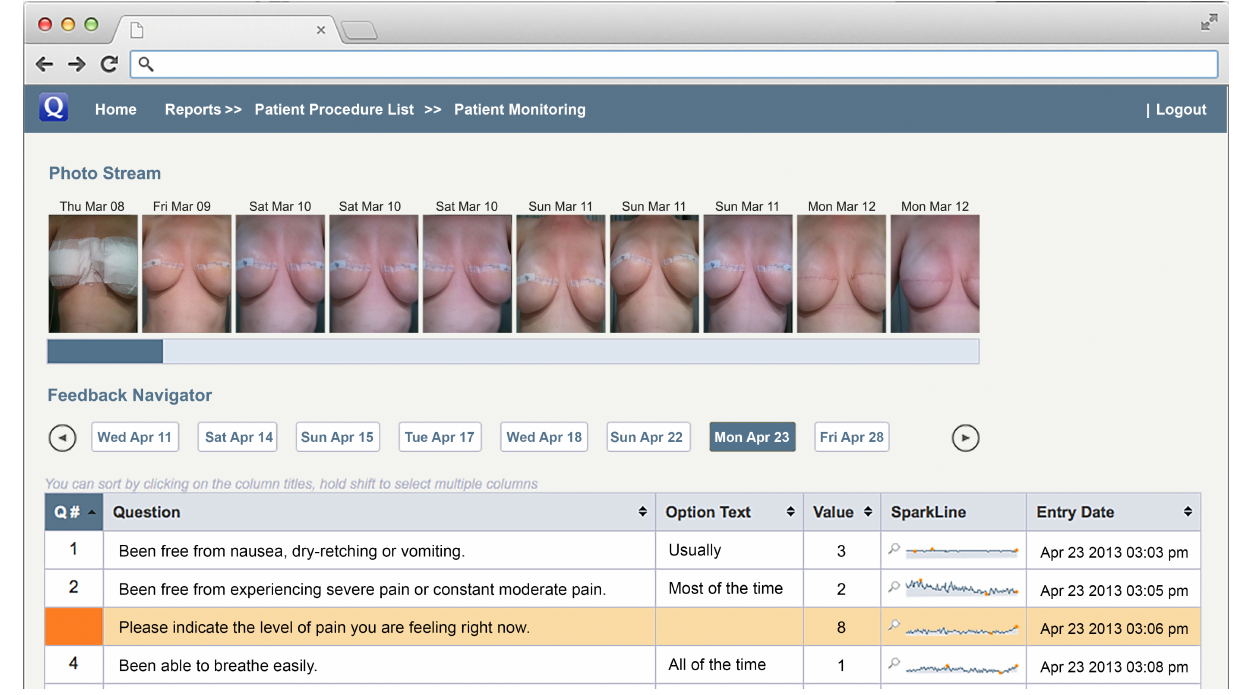
Figure 3. Surgeon's dashboard: The surgeon or care provider can view the patient's quality of recovery all on one screen. The photos show the patient's "selfies" of the surgical site with the date. The QoR-9 questions are listed with the responses. Question #3 is highlighted red because of the abnormally high pain score entered by the patient. The "spark line" represents every score as a point of data on that particular indicator since the start of the monitoring. The pictures can be enlarged by tapping on